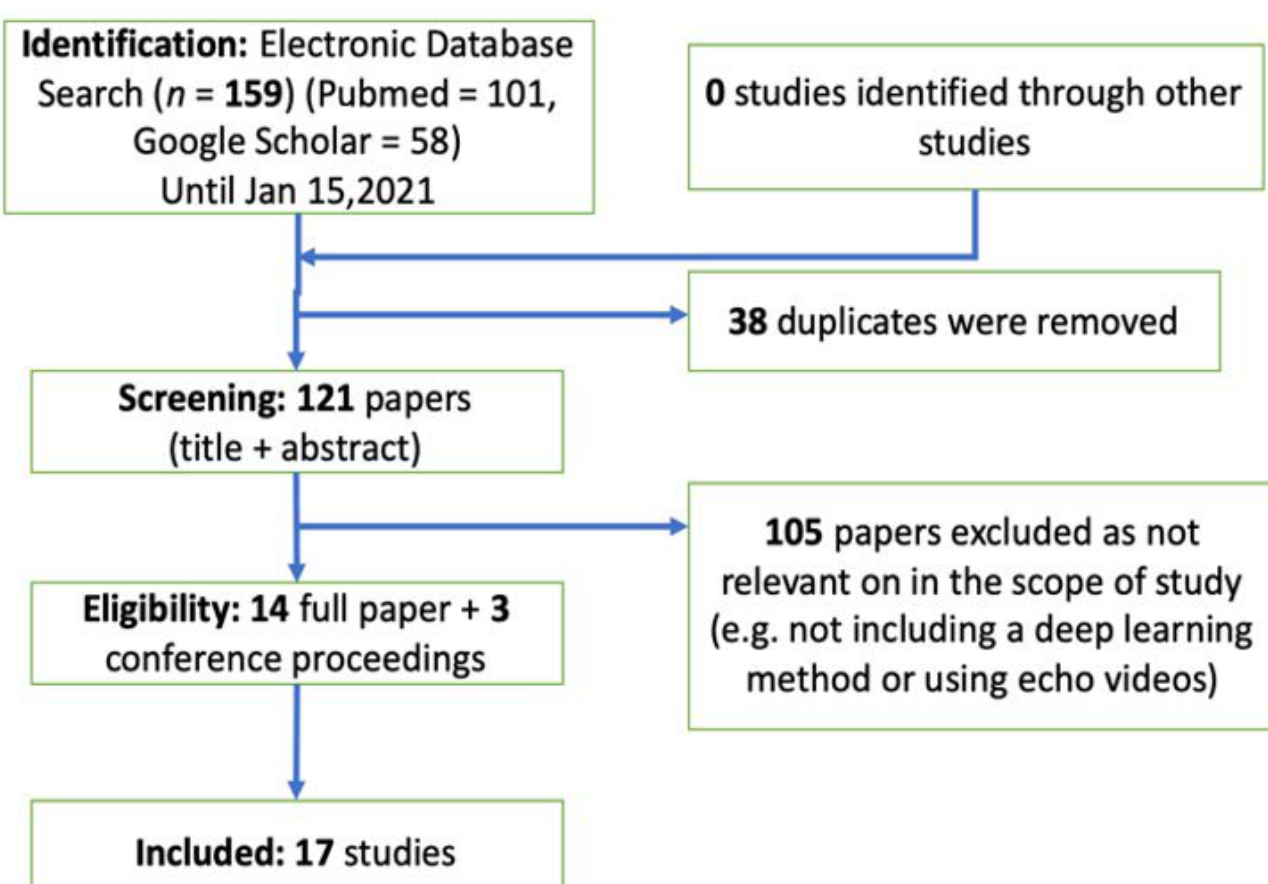
Figure 4. The flowchart of systematic review that includes identification, screening, eligibility, and inclusion.